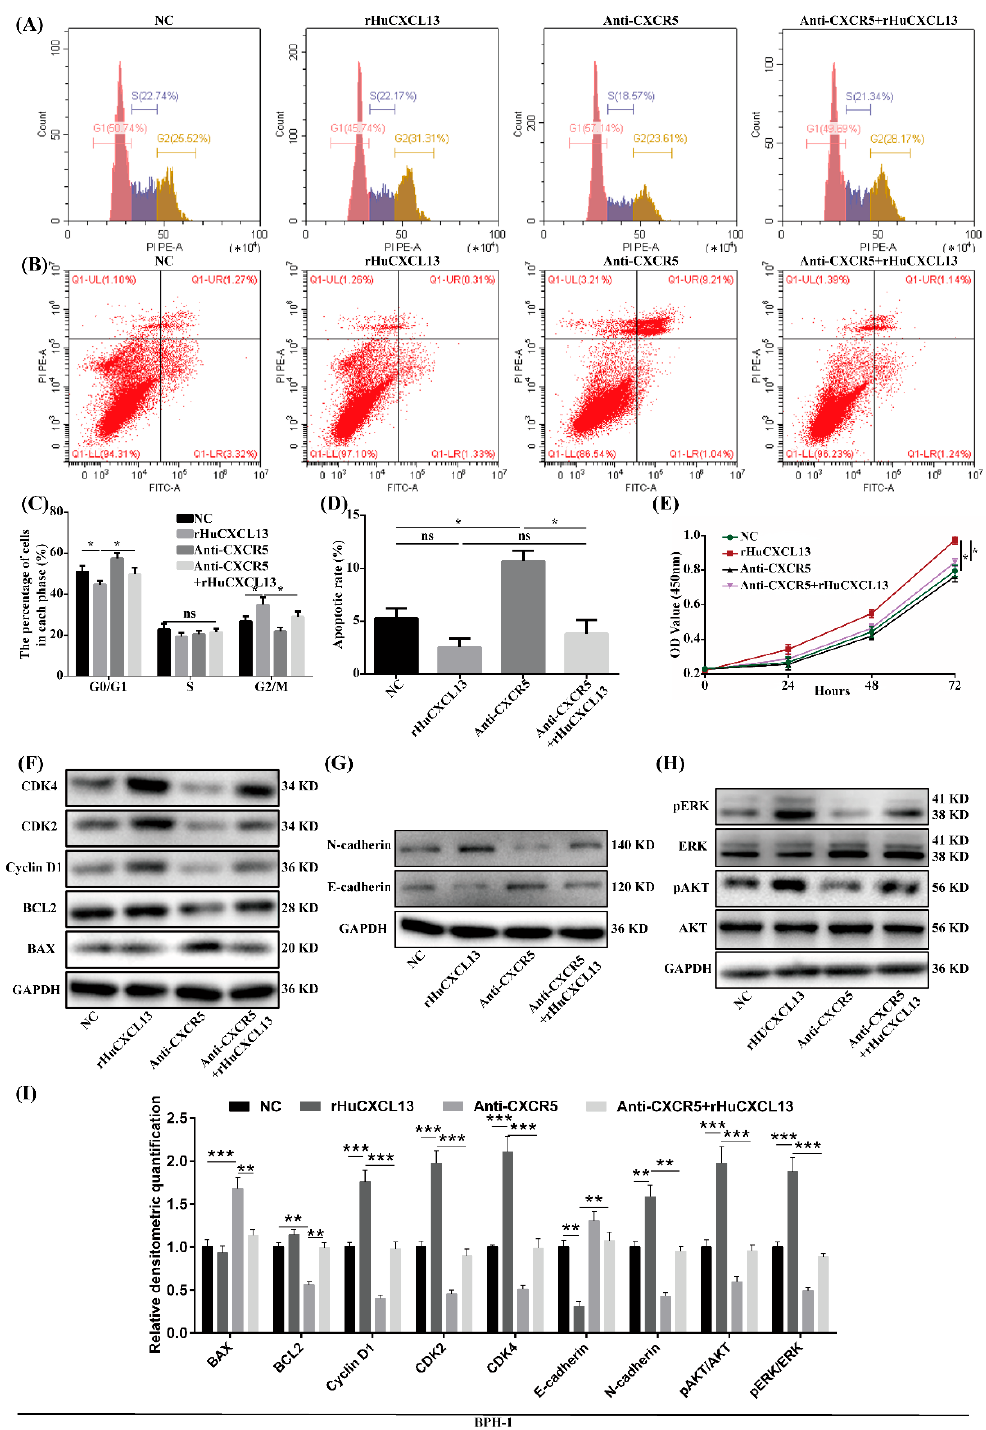
(Figure 5). Similarly, anti-CXCR5 also rescued the alternations of fibrosis and inflammation induced by rHuCXCL13 in WPMY-1 cells (Figure 6).